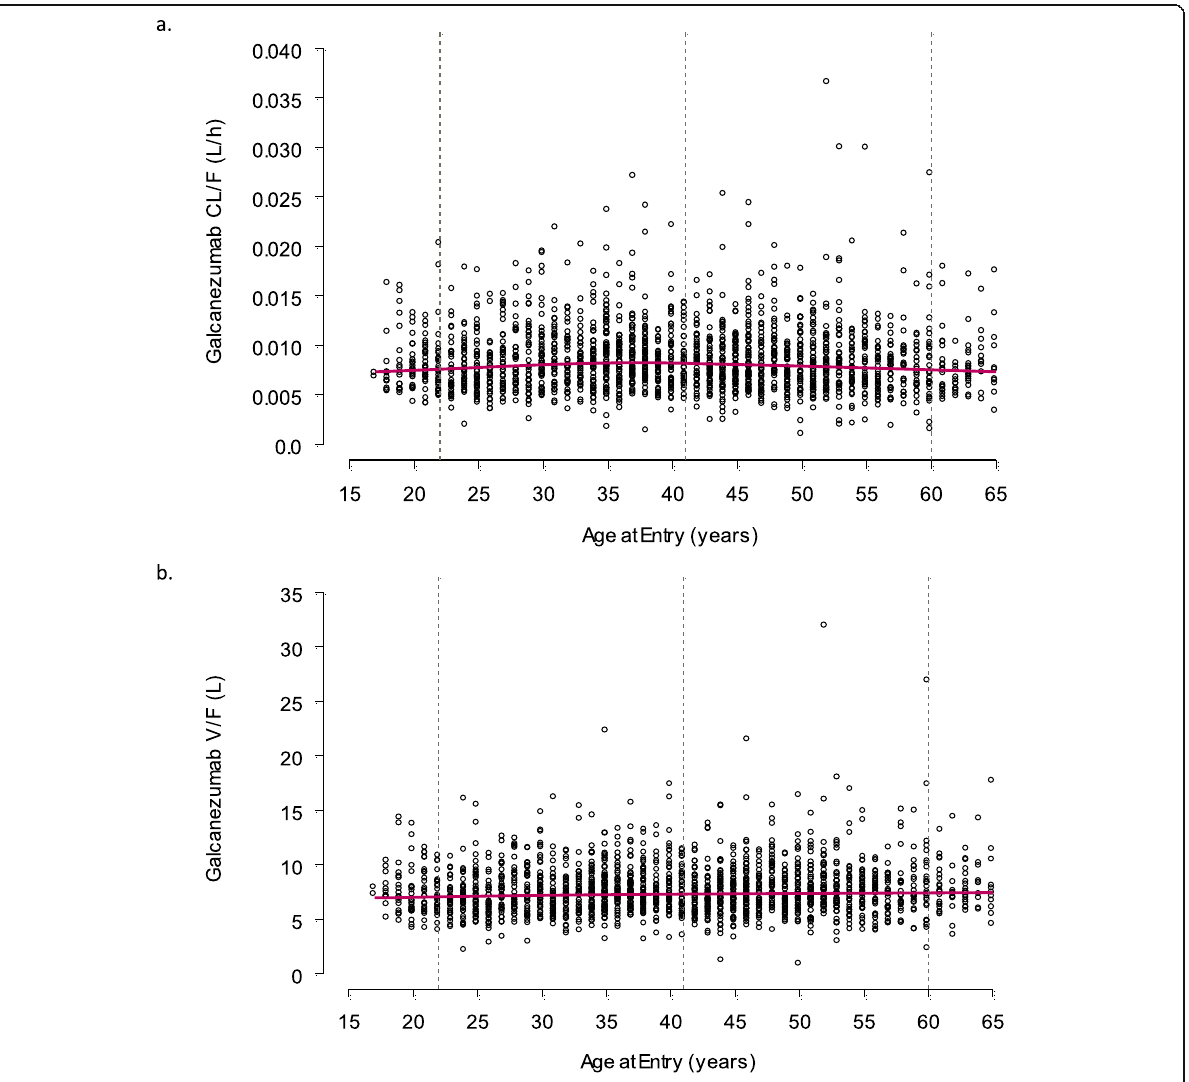
Fig. 1 Effect of age (18 – 65 years) on galcanezumab CL/F and